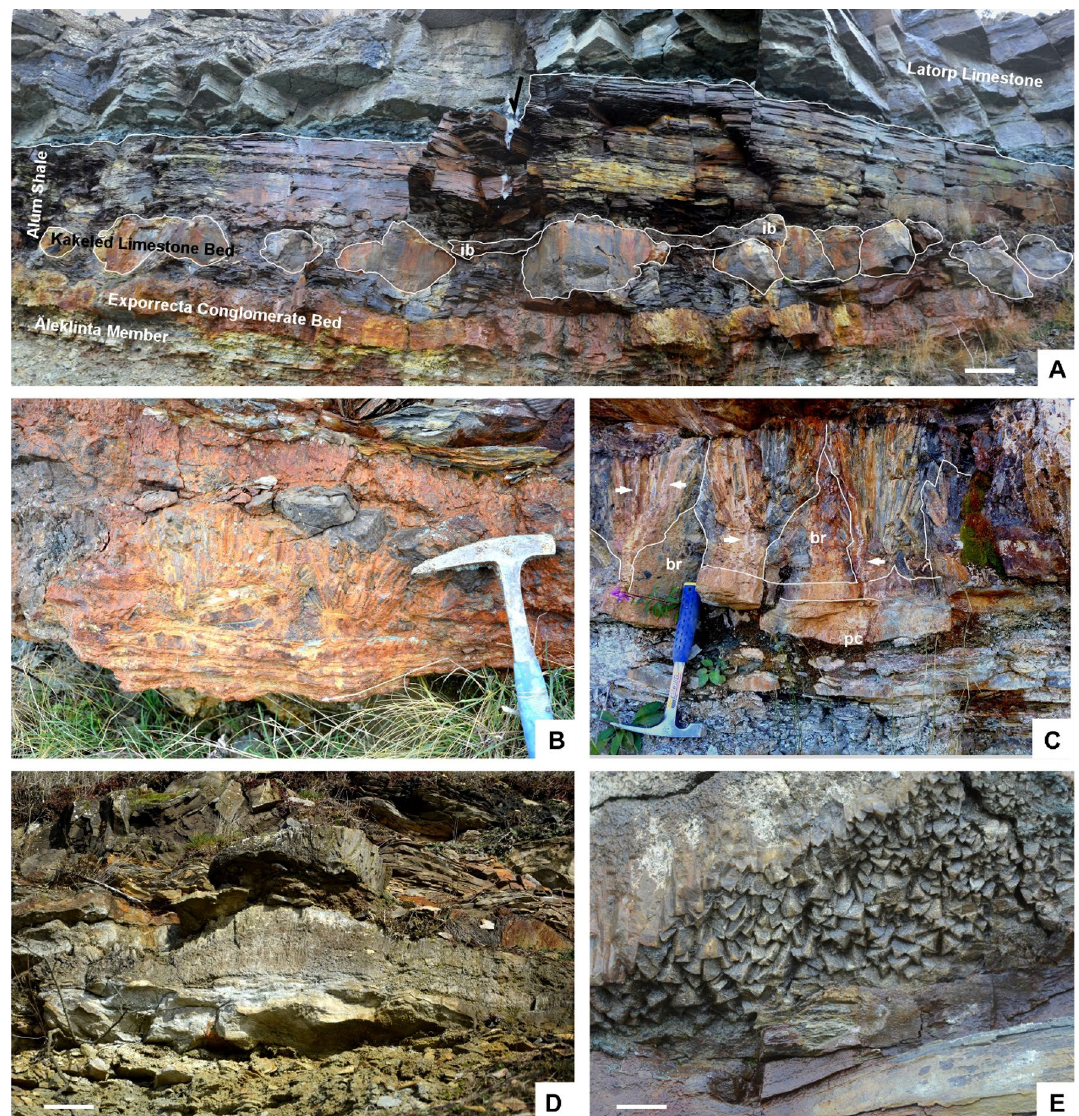
Figure 2. Field aspect of the metalliferous carbonate mounds described in the text. ( A) General view of Alum Shale/Latorp Limestone faulted contact (arrowed) at Bruddesta highlighting the disconnected aspect of the limestone intervals of the Kakeled Limestone Bed, laterally interrupted by intraformational breccia levels ( ib ); scale bar = 10 cm. ( B) Close up view of the Exporrecta Conglomerate Bed showing alternations of conglomerate lags encrusted by glendonitic radiating fans. ( C ) View of coalescing stellate glendonite fans forming a blanket, interrupted by whitened hydrothermal veins (arrows); br sulphide-bearing breccia lens, pc palisade crust. ( D) Mound of the Kakeled Limestone Bed embedded in the uppermost part of the Alum Shale at Degerhamn; scale bar = 10 cm. ( E) Basal surface of a glendonitic blanket showing the pyramidal end of the glendonitic crusts at Bruddesta; scale bar = 1